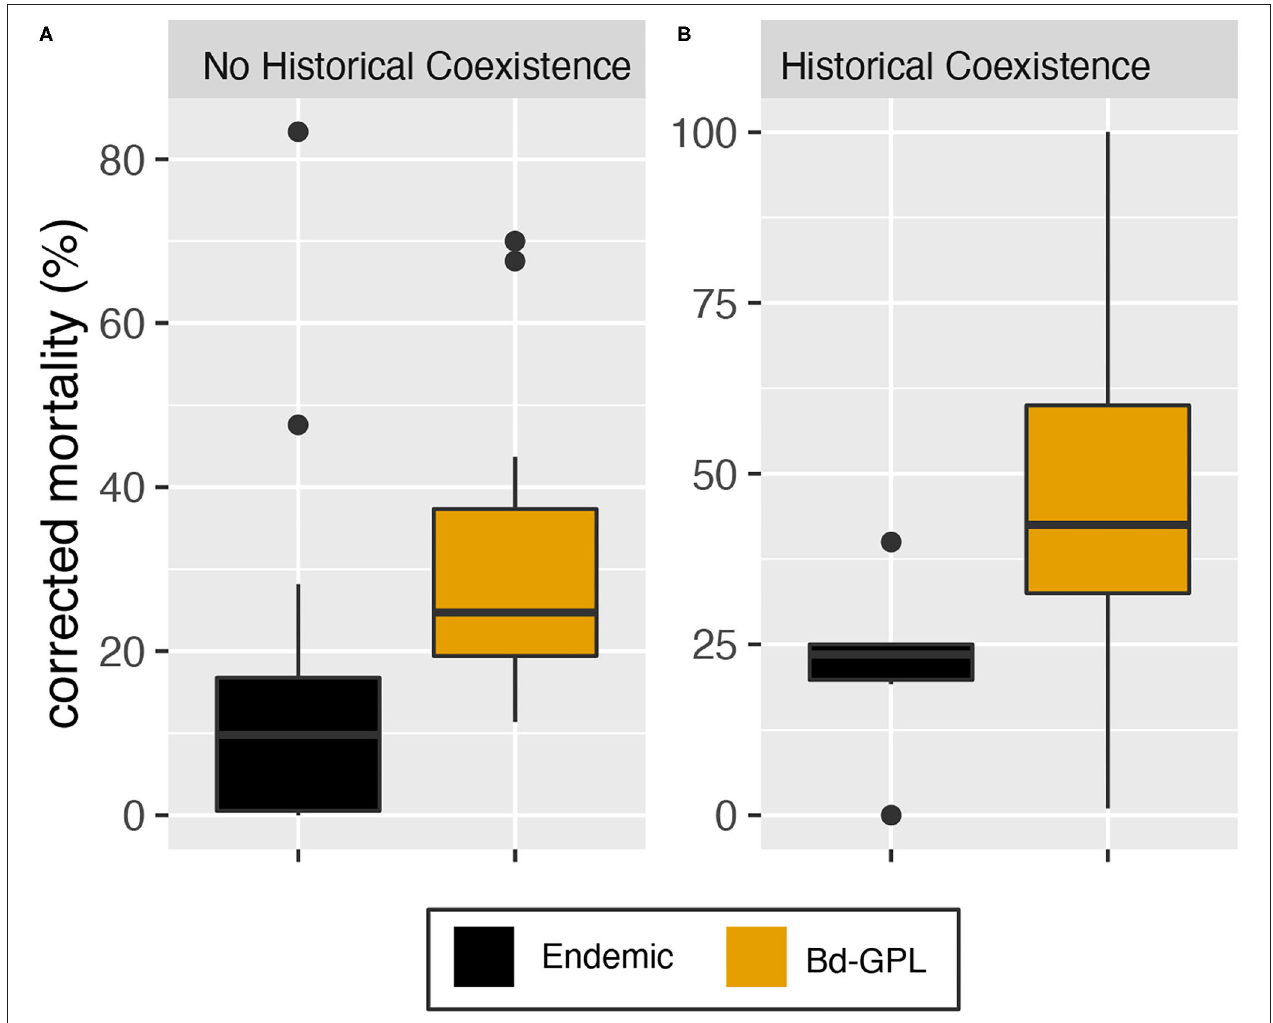
FIGURE 3 | Mortality outcomes pooled by Bd lineage. (A) Mortality in species that have not historically coexisted with the endemic Bd used in the experiment. (B) Mortality in species that have historically coexisted with the endemic Bd used in the experiment. Mortality values have been corrected for background (control treatment) mortality. Endemic Bd-associated mortality is depicted in black and Bd-GPL-associated mortality is depicted in